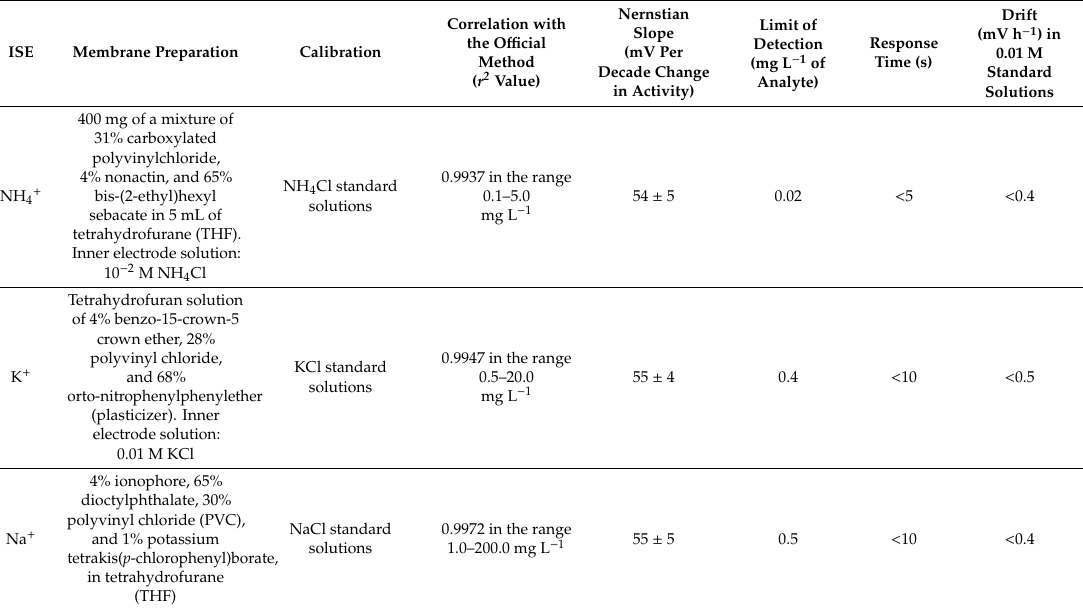
Table 1. Characteristics of the three ion selective electrodes (ISEs)